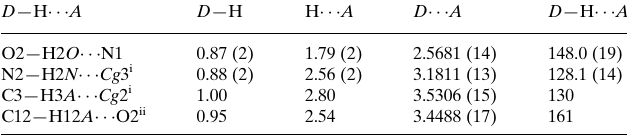
Hydrogen-bond geometry (A˚ , (cid:2) ). Cg 2 and Cg 3 are the centroids of rings C4–C8/C13 and C8–C13,